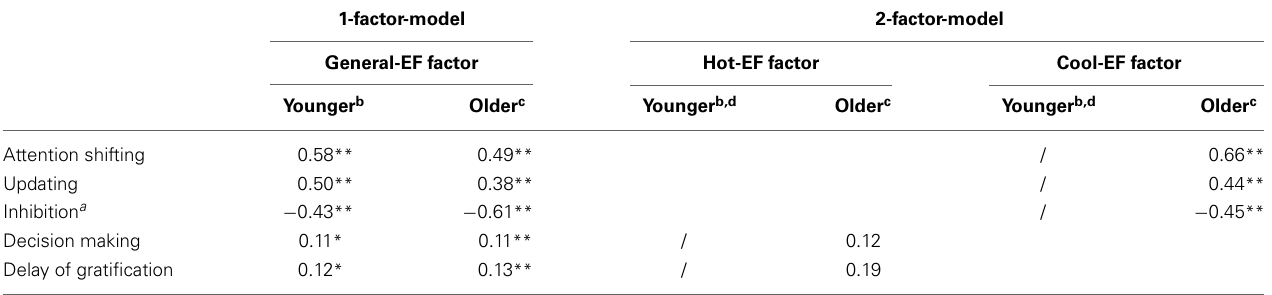
Table 2 | Standardized factor loadings for EF tasks on the one- and two-factor model in the younger ( < 8.4 years) and older ( > 8.4 years) half of the